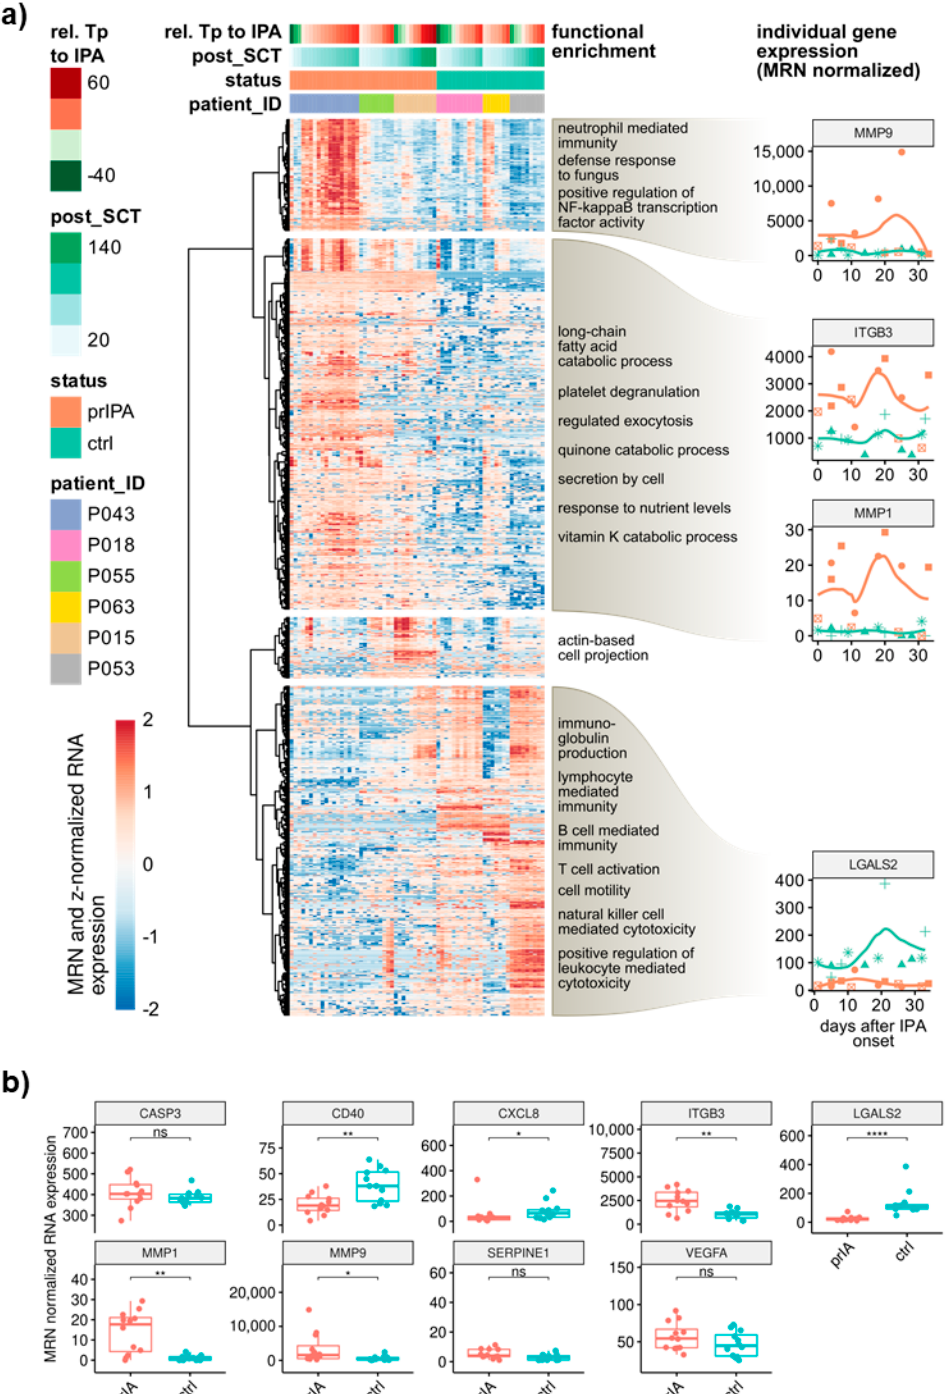
Figure 2. Transcriptome profiling of whole blood collected from three probable IPA patients and their matched controls. Blood samples were collected after alloSCT, twice-weekly whenever feasible and were investigated by RNA sequencing. ( a ) Hierarchical clustering and functional enrichment of genes differentially expressed across all collected blood samples in investigated probable IPA patients (red) and their matched controls (green) ( p < 0.05, log2FC cutoff 0.8). Individual gene expression line plots refer to expression at days after IPA onset. ( b ) Median-ratio-normalized (MRN) RNA expression of selected candidates within the first 5 weeks after IPA onset (balanced dataset). Significance between IPA cases and control patients was tested by the Wilcoxon test (ns, not significant; *, p < 0.05; **, p < 0.01; ****, p < 0.0001).